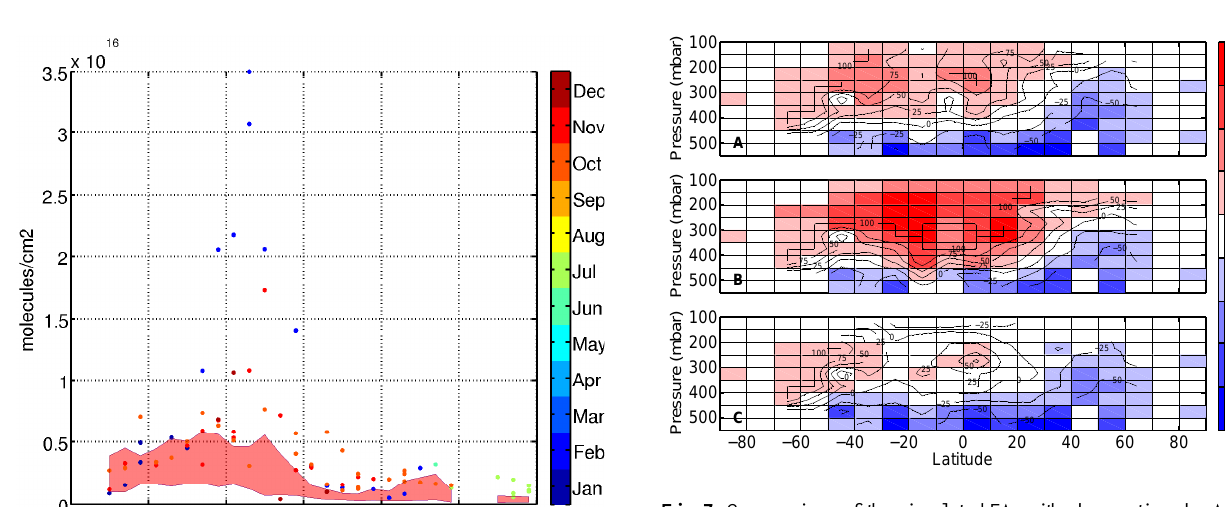
Fig. 7. Comparison of the simulated FA with observations by ACE- FTS suggests an altitude-dependent error. Increasing the reaction rate of OH with FA reduces the model high-bias in the upper tro- posphere (C) while injection of biomass burning in the free tropo- sphere provides little improvement in the middle troposphere while degrading FA simulation in the upper troposphere (B) . Absolute difference between the model and the ACE-FTS measurement is shown in pptv with contours indicating the relative difference in % ((model-measurement)/measurement). Cells with no measurements are grayed. Panel (A) shows the comparison for the reference run (R1), Panel (B) for R2b and Panel (C) for R4 (see Sect. 4). The model is sampled at the location and time of the ACE-FTS mea-